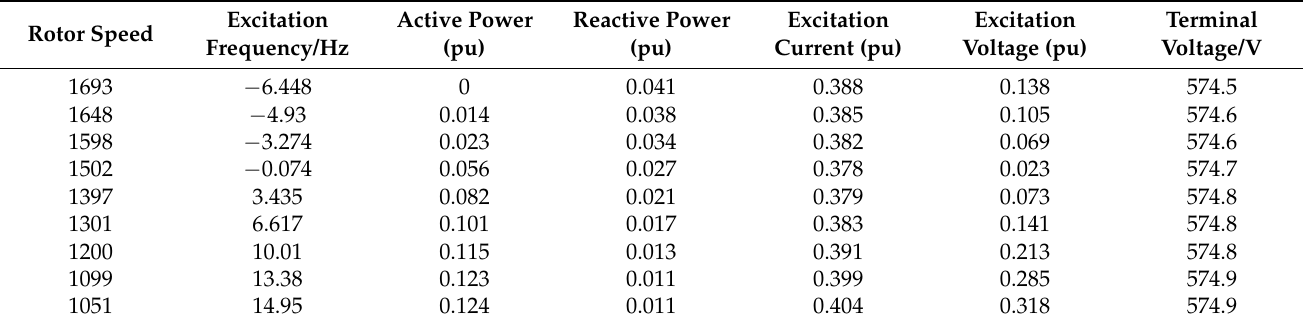
Table 2. The change in rotor speed at a given power at a wind speed of 7 m/s.